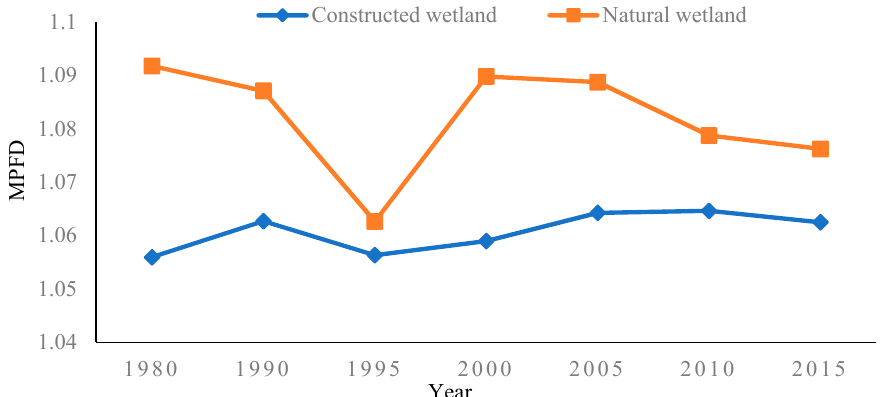
Figure 5. The mean patch fractal dimension (MPFD) of constructed and natural wetland from 1980 to 2015.